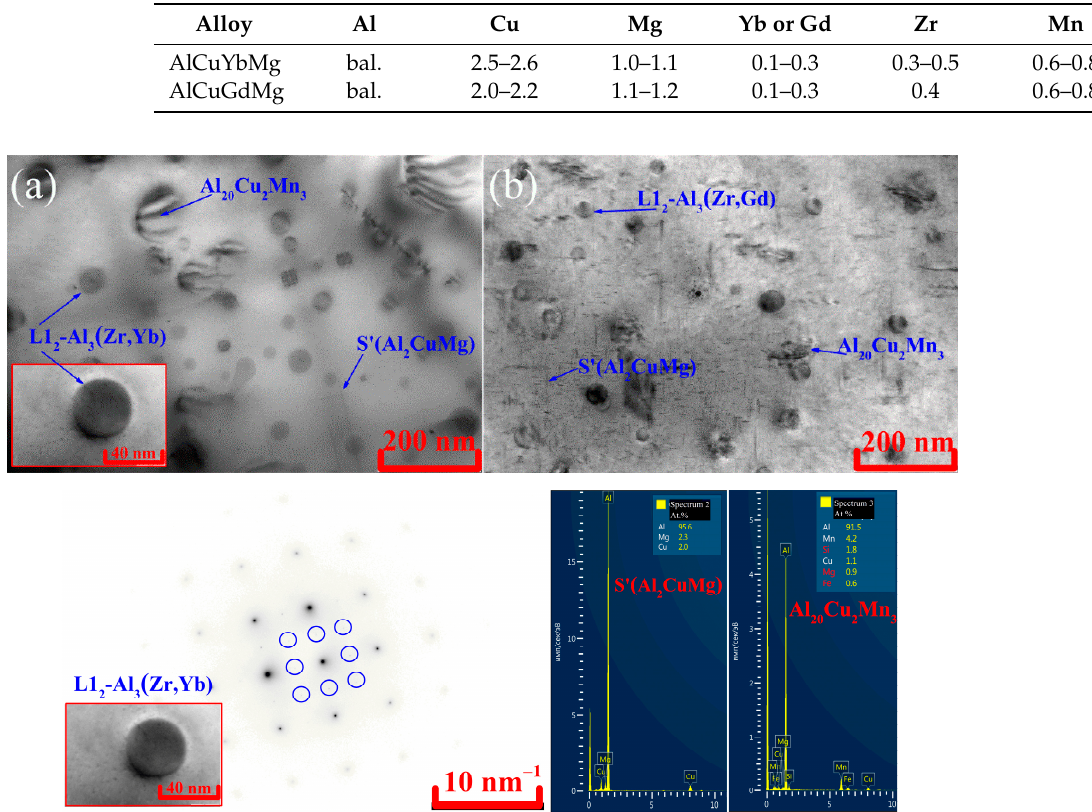
Figure 5. Microstructures of the ( a ) AlCuYbMg and ( b ) AlCuGdMg alloys after 3 h of solution treatment at ( a ) 555 °C and ( b ) 565 °C, quenching and aging at 210 °C for 3 h, and FFT pattern of L1 2 -Al 3 (Zr,Yb), and EDX spectrum from S’ and Al 20 Cu 2 Mn 3 phases (TEM). AlCuYbMg and AlCuGdMg alloys were aged at 150, 180 and 210 °C after 3 h of so- lution treatment and quenching. HV vs. time dependences are presented in Figure 6. After being supersaturated by Cu and Mg, and after quenching, the Al solid solution decomposed with S’(Al 2 CuMg) precipitates nucleation. The highest hardening effect was achieved after 3 h of aging at 210 °C in both alloys due to S’(Al 2 CuMg) precipitates. Typical disk-shaped precipitates are identified in the TEM images in Figure 5. Figure 6. Aging curves of the ( a ) AlCuYbMg and ( b ) AlCuGdMg alloys . Table 4 and Figure 7 demonstrate the results of the tensile test and typical tensile curves at different temperatures of quenching and aging at 210 °C for 3 h alloys. The UTS of the AlCuYbMg and AlCuGdMg alloys at room temperature are 338 and 299 MPa, re- spectively. For comparison, commercial Al-5Cu-0.8Mn alloys have the same UTS of 313– 334 MPa [2]. However, the casting properties of the novel alloys are better. The HCI of the AlCuYbMg and AlCuGdMg alloys is 12–14 mm but for commercial Al-5Cu-0.8Mn alloys it is closer to 16 mm [2–5]. The UTS decreases to 219–270 MPa with an increase in the temperature of the tensile test to 200–250 °C. At the same time the elongation signif- icantly increases. The rupture stress at 250 °C for 100 h under stress is 111–113 MPa. For comparison, the rupture stress at 260 °C for 100 h under stress is 95 MPa for a commercial 201.0 Al alloy [2]. Novel AlCuYbMg and AlCuGdMg alloys are a potential option for castings for high temperature application. Table 4. Tensile test results at indicated temperature . Alloy